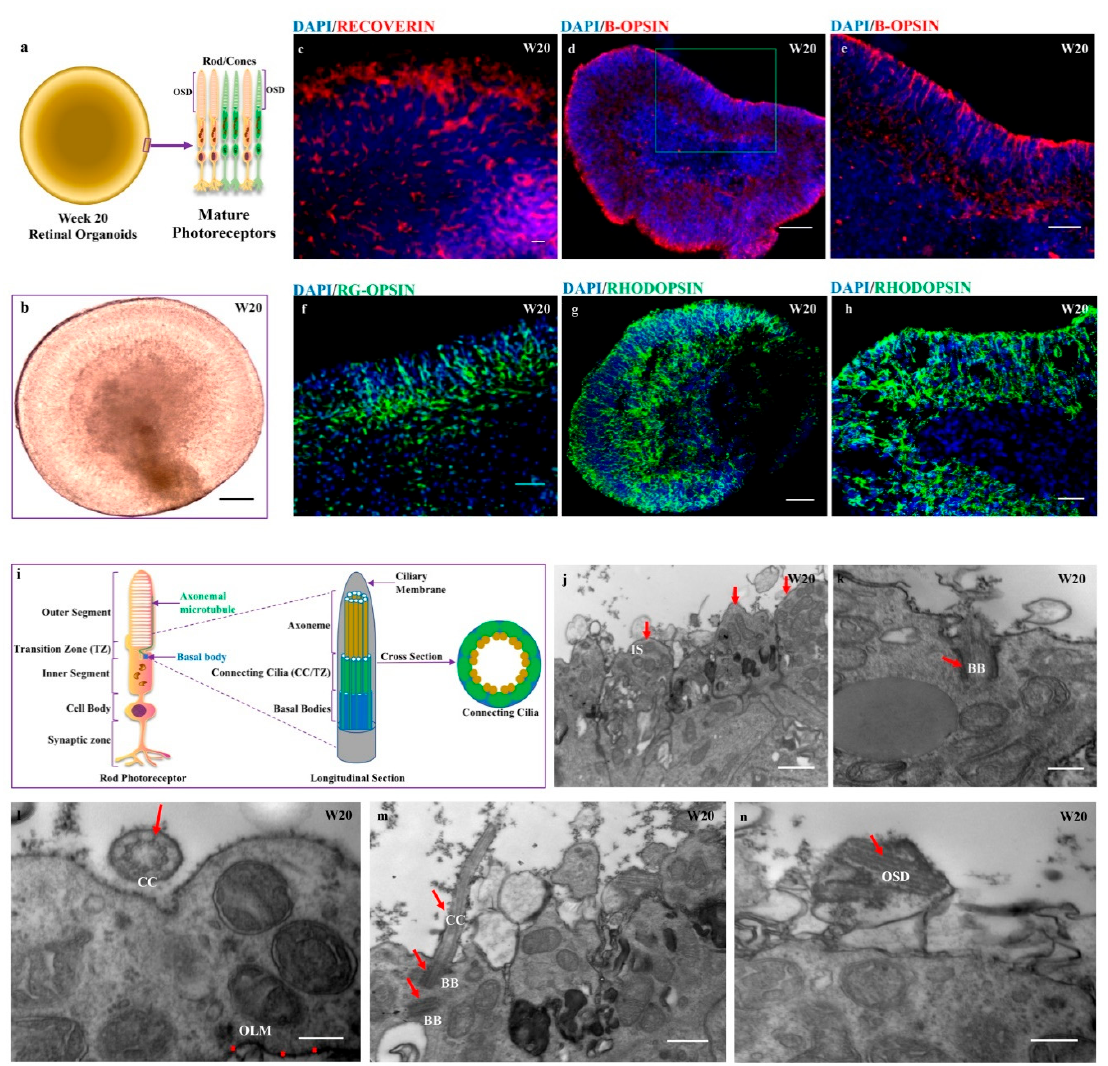
Figure 7. hiPSC-derived 3-D retinal organoids in long-term culture acquire mature photoreceptors with the formation of the outer-segment disc. ( a ) Illustration of week 20 retinal organoids showing mature photoreceptors (rod/cones) with stacks of the outer-segment disc (OSD); ( b ) Representative images of retinal organoids; ( c ) Immunohistochemistry staining of cryosectioned organoids expressing RECOVERIN ; ( d , e ) and B-OPSIN ; ( e ) Enlarged part of image d is shown in green box in image d ( f ) RG-OPSIN ; and ( g , h ) RHODOPSIN markers; ( i ) Illustration showing longitudinal and cross sections of rod photoreceptors; and ( j – n ) transmission electron microscopy (TEM) analysis of week 20 organoids shows the presence of distinct compartments of the sensory cilia-like inner segment (IS) of the photoreceptors ( j ); basal bodies (BB) with protruding cilia ( k ); cross section of connecting cilia (CC) and outer limiting membrane (OLM) ( l ); long extended axoneme of connecting cilia with basal bodies ( m ); and stacks of the outer segment disc packed with rhodopsin ( n ). The functional domains with red arrows and cross marks in the respective images. Scale bars, 50 µ m ( f ); 100 µ m ( c – e ); 200 µ m ( b , g , h , j – n ).